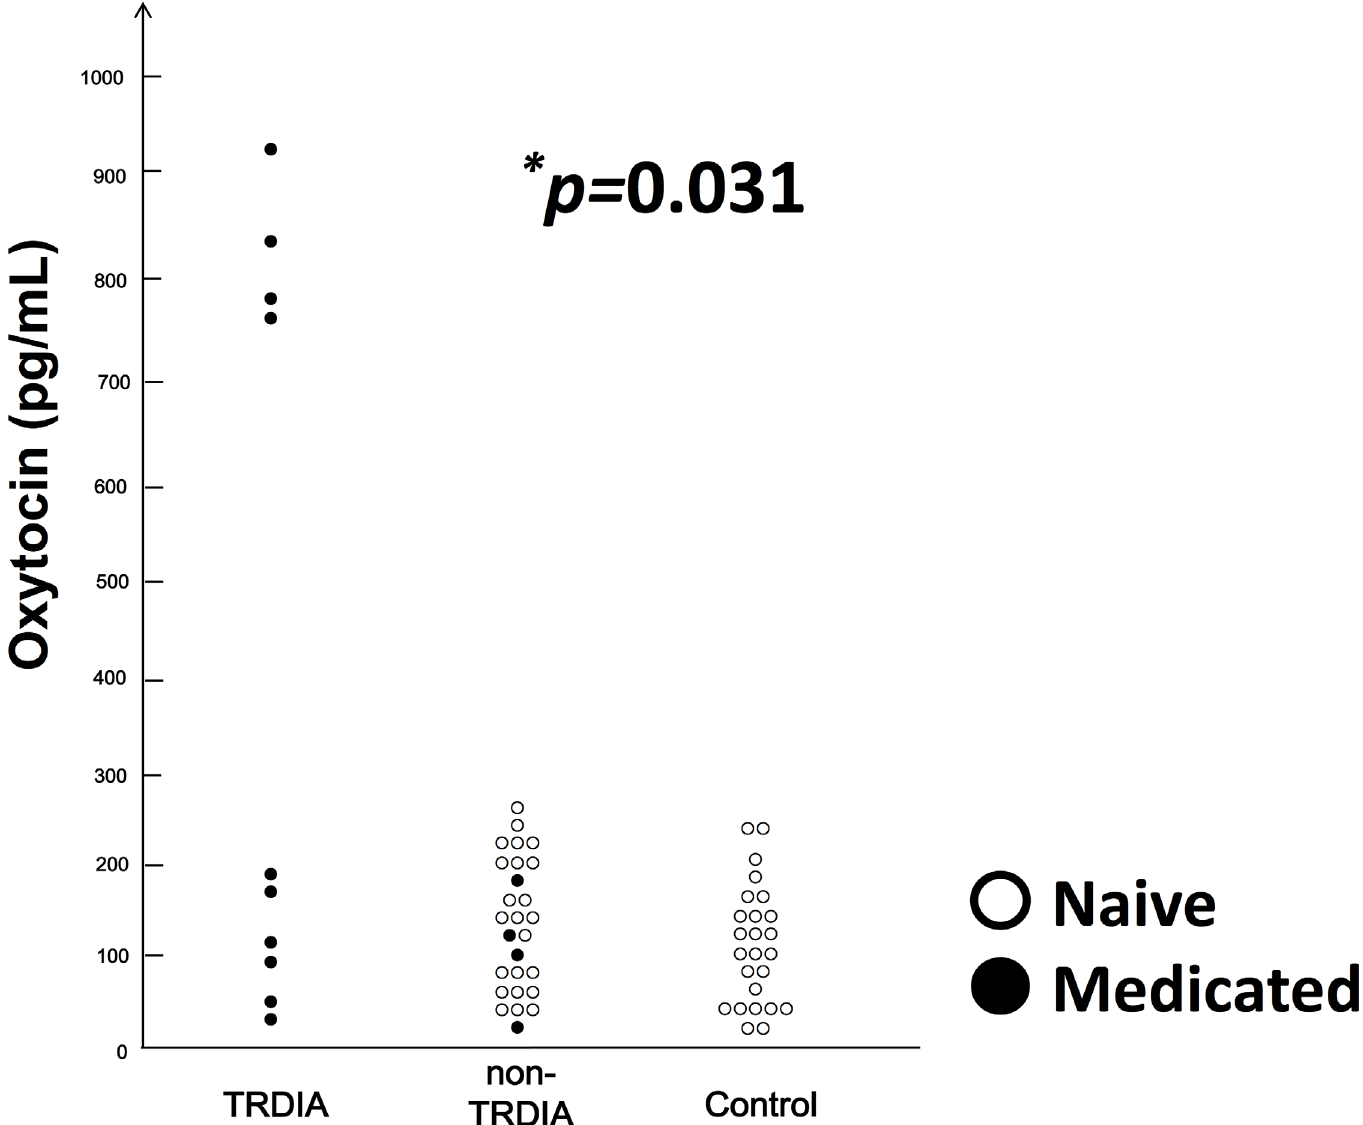
Fig 1. The serum levels of OXT in TRDIA, non-TRDIA and controls. (cid:3) is drug na ï ve subjects. ● is medicated patients. Kruskal-Wallis test detected significant ( p = 0.031) differences in OXT serum levels among the TRDIA patients (n = 10), non-TRDIA patients (n = 27) and controls (n = 25). Abbreviations: OXT, Oxytocin; TRDIA, treatment resistant depression in